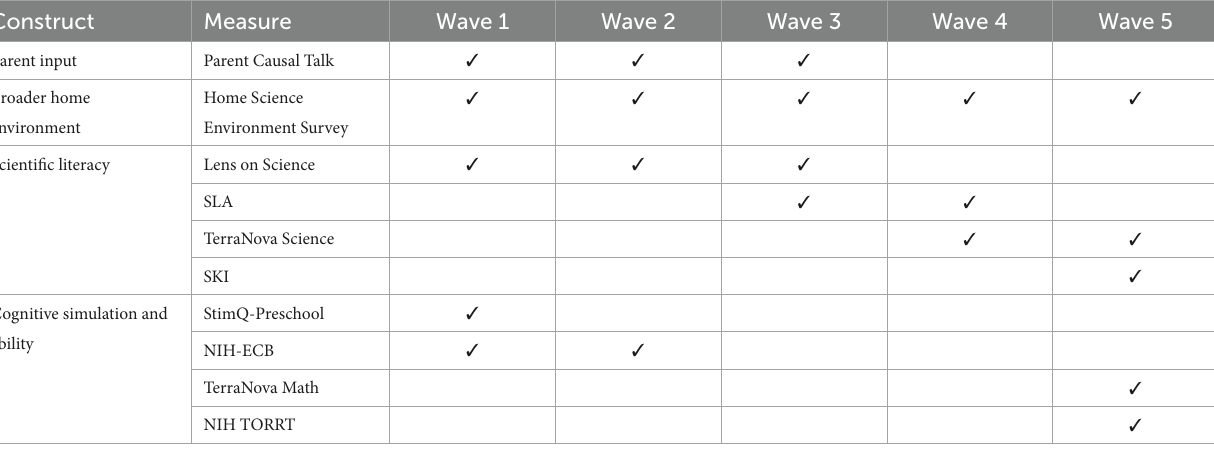
TABLE 3 Measures used at each timepoint of data collection.